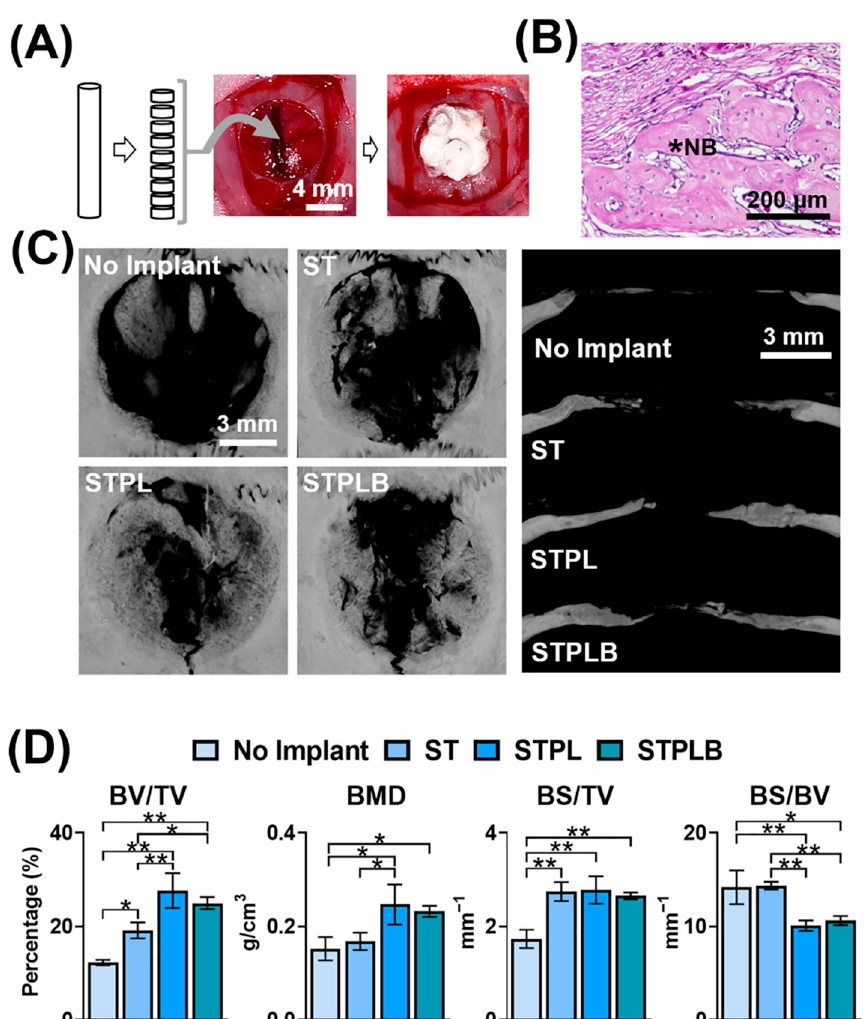
Figure 8. ( A ) Schematic flow chart of the animal experiments. Sliced gelatin sponges were implanted in critical-sized bone defects of rat calvaria. ( B ) Representative hematoxylin–eosin staining image of the defects (the defect treated with the gelatin sponges prepared using STPL is presented). *NB: newly formed bone. ( C ) Vertical and lateral microcomputed tomography (µCT) images of bone defects treated with/without gelatin sponges prepared using different molds. Three weeks after surgery. ST: silicon tube showing high permeability; STPL: ST covered with PVDC at the lateral side; STPLB: ST covered with PVDC at the lateral and bottom sides. ( D ) Bone morphometry analysis of newly formed bone using µCT. Mean with SD ( n = 3). BV, bone volume; TV, total volume; BMD, bone mineral density; BS, bone surface. * p < 0.05, ** p < 0.01, one-way ANOVA with Tukey–Kramer tests.